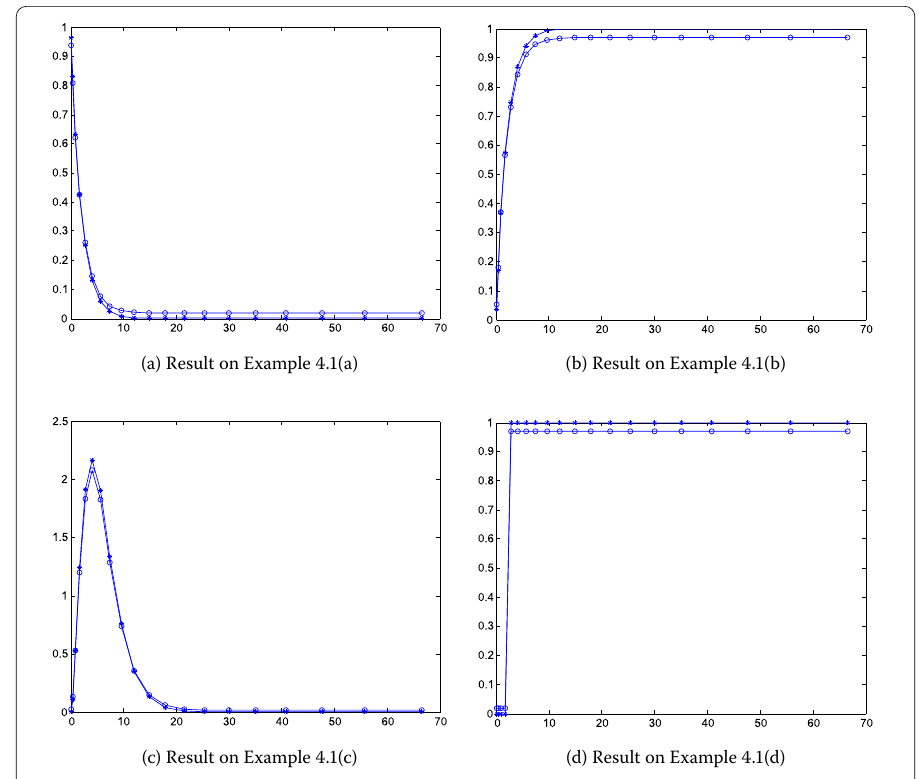
Figure 1 Numerical results on Example 4.1: ‘ ∗ ’ is the true solution and ‘ ◦ ’ denotes the approximate